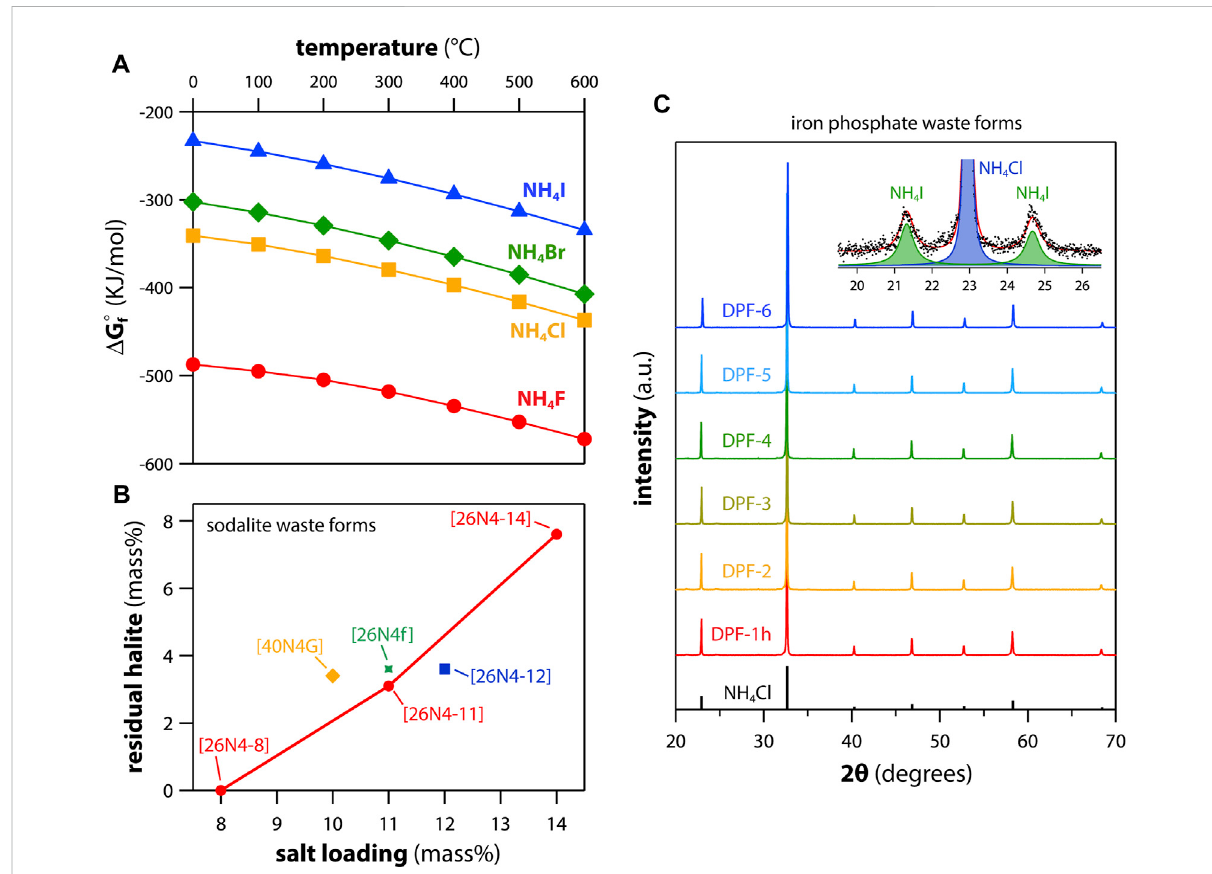
FIGURE 1 (A) Gibbs free energies of formation for various ammonium halide salts (Riley et al., 2020). (B) Residual halite (NaCl) mass, based on X-ray diffraction data, as a function of salt loading used to make glass-bonded sodalite waste forms showing that residual salts are observed when the salt fractions are too high ( > 8 mass%) due to crystal stoichiometry limits (Riley et al., 2017). (C) Powder X-ray diffraction data showing the majority phase of NH 4 Cl with a minor NH 4 I phase in solid condensates recovered after a reaction between NH 4 H 2 PO 4 and a Cl/I-containing salt simulant at temperaturesupto600 ° Cinanaluminacrucible(Rileyetal.,2020).Parts (A,C) ofthis fi gureweremodi fi edfromtheoriginalsbyRileyetal.(2020)and werereprintedwithpermission.CopyrightElsevier(2020).Part (B) wasmodi fi edfromtheoriginalbyRileyetal.(2017)andreprinted withpermission. Copyright Elsevier